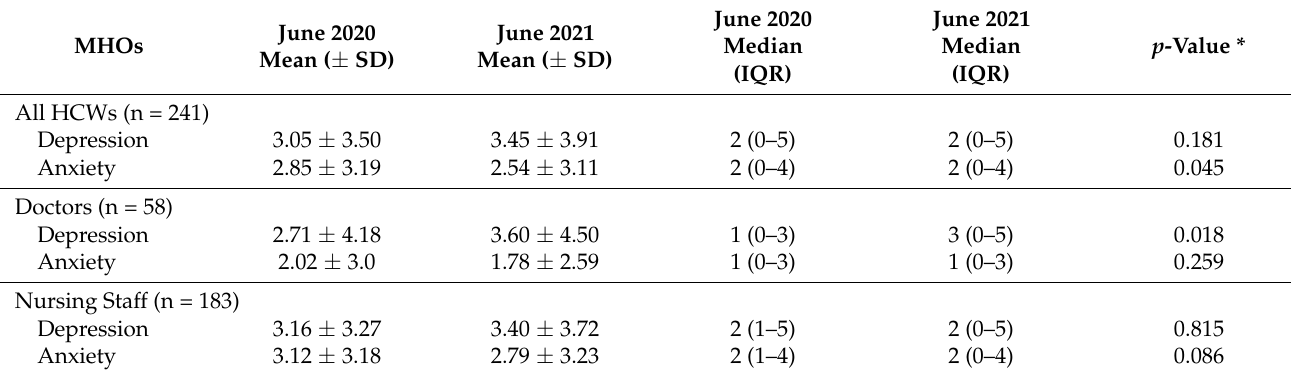
Table 3. Depression and anxiety scores amongst matched HCWs (n = 241) and its subgroups of doctors (n = 58) and nursing staffs (n =